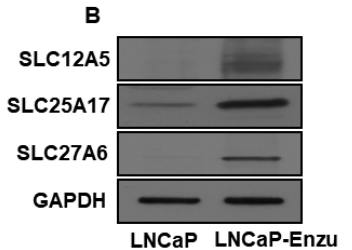
Figure 8. ( A ) Glycolytic end product metabolic uptake assay performed in LNCaP (parental) and LNCaP enzalutamide resistant cells. Glycolysis end products viz. glucose uptake, citric acid, and lactic acid were measured. LNCaP enzalutamide cells showed elevated level of citric acid ( p value = 0.05) and lactic acid ( p value = 0.01); whereas glucose uptake was higher in LNCaP cells compared to LNCaP enzalutamide resistant cells ( p value = − 0.01). Bar represents the standard error mean (SEM) for three biological and three technical replicates. * p < 0.05, ** p < 0.001, LNCaP versus LNCaP enzalutamide resistant cells. ( B ) Western blotting for protein expression of SLC12A5, SLC25A17, SLC27A6 in LNCaP, and LNCaP enzalutamide resistant cells. GAPDH expression as a loading control.